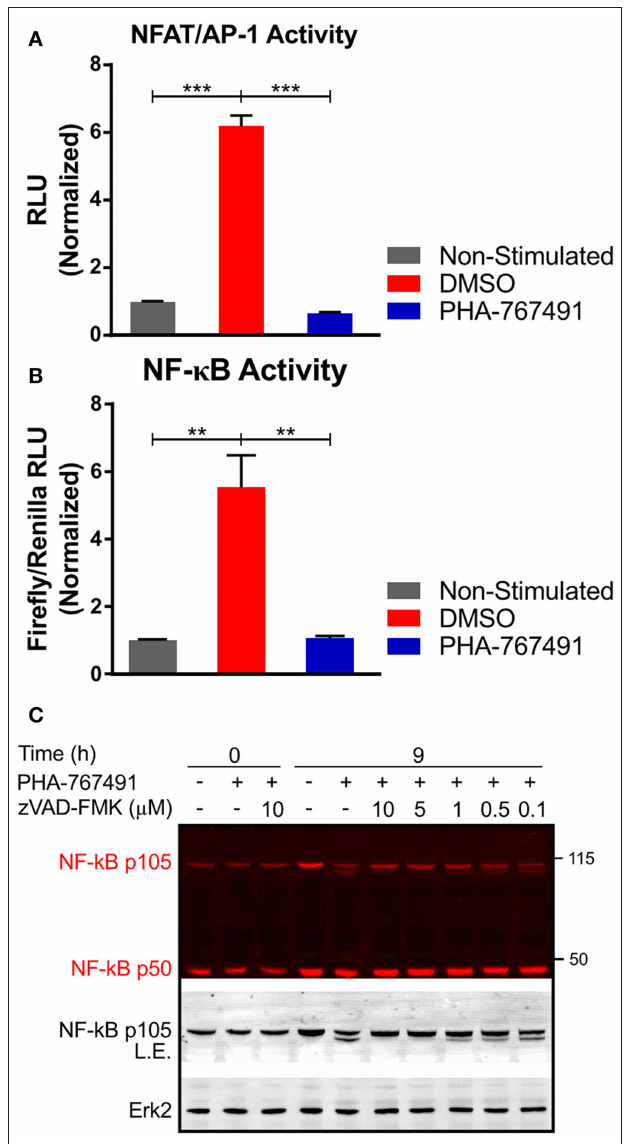
FIGURE 8 | PHA-767491 suppresses activity of transcription factors. (A) PHA-767491 impairs the activity of NFAT/AP-1. NFAT/AP-1-luciferase reporter Jurkat cells were treated with DMSO or PHA-767491 and stimulated with plate-bound CD3 antibodies for 6h. (B) PHA-767491 impedes NF- κ B activity. NF- κ B-firefly luciferase and Renilla luciferase control plasmids were electroporated into Jurkat cells. The electroporated cells were cultured in hygromycin selection media before the assay. The NF- κ B-firefly luciferase containing Jurkat cells were treated with DMSO or PHA-767491 and stimulated with plate-bound CD3 antibodies for 6h. NF- κ B activity is established as a ratio of the NF- κ B-dependent firefly luciferase over the Renilla luciferase control. Data shown is representative of at least three independent experiments. Bar charts, represented as mean ± SEM, have been normalized to the NS sample. Statistical significance was determined by unpaired two-sided Student’s t -test (** p < 0.01; *** p < 0.001). (C) Immunoblots of Jurkat cell lysates that were not-treated (–) or treated ( + ) with PHA-767491 and stimulated with plate-bound anti-CD3 antibodies for 9h. Samples were either treated with zVAD-FMK at the indicated concentrations or not-treated with the caspase inhibitor. Representative blots of at least three independent experiments are